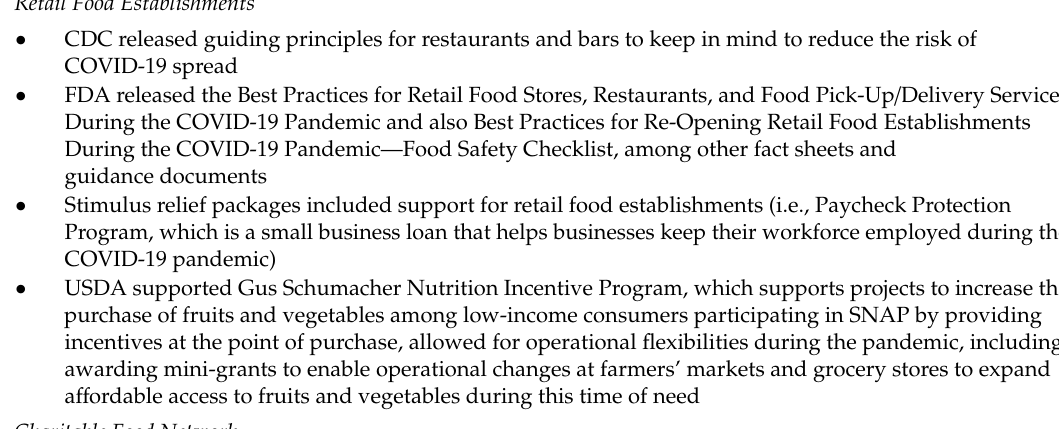
Table 2. Selected US federal government COVID-19 initiatives targeting the retail food environment and customers